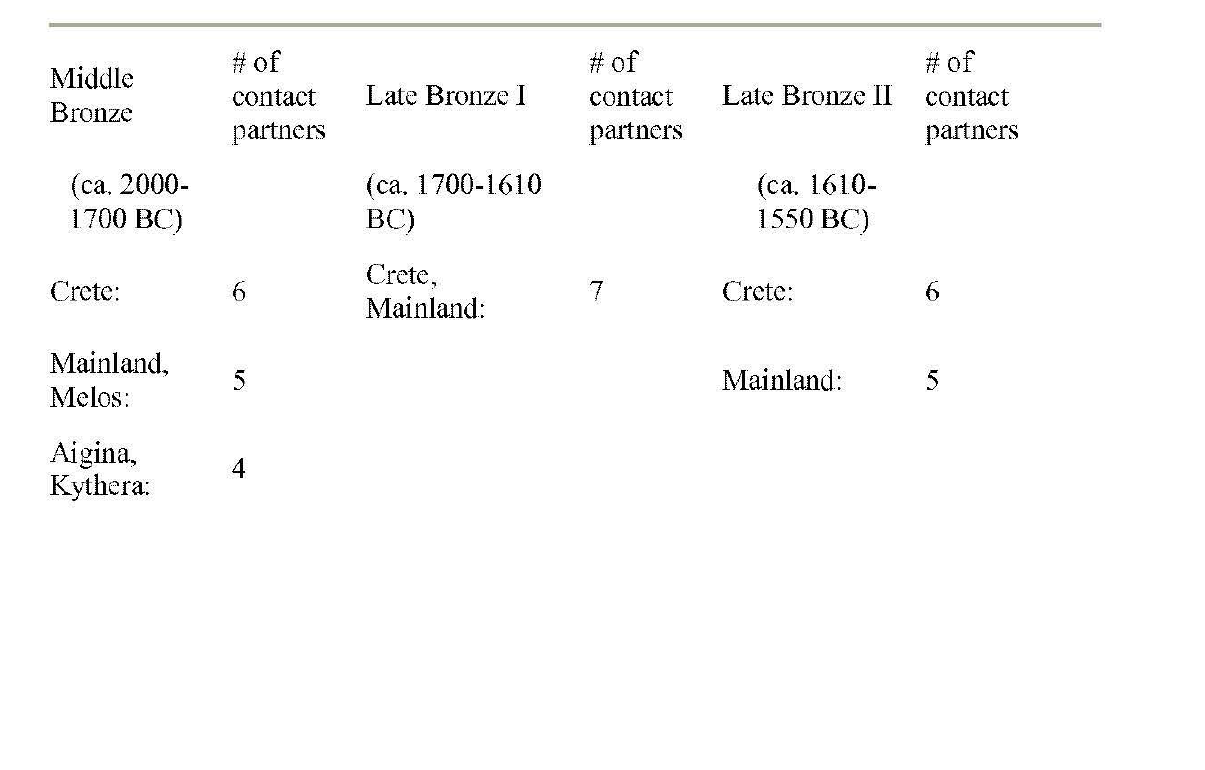
Table 1:The Southern Aegean network in the Middle Bronze Age (sec Map 2a)